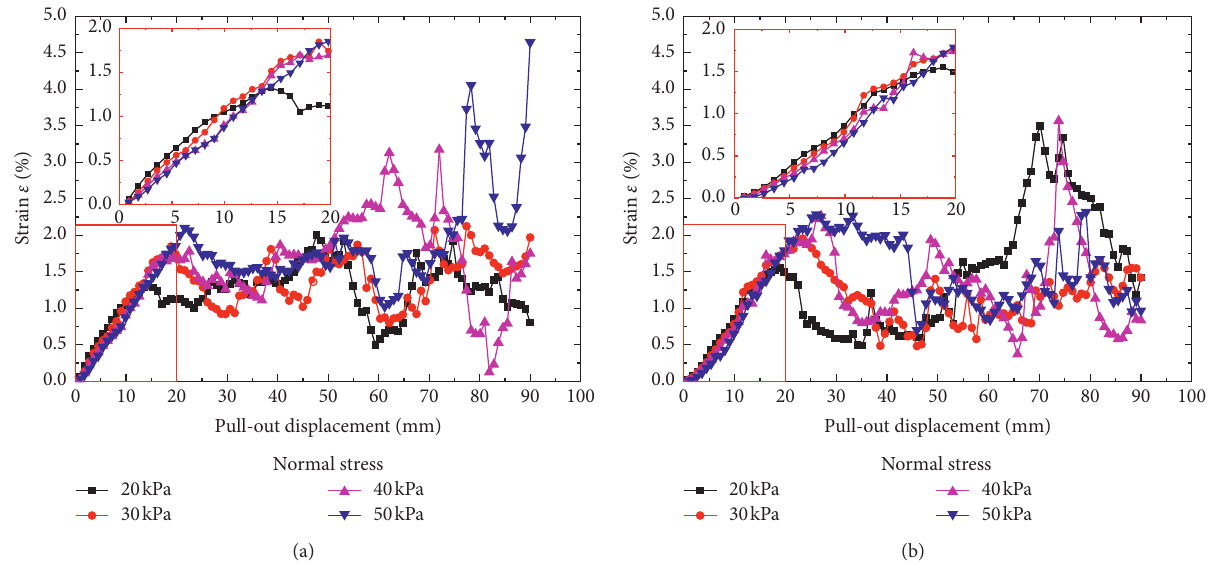
Figure 11: Relationships between the sectionalized strain of geogrid and displacement. (a) BG3 and (b) BG3 ′ .